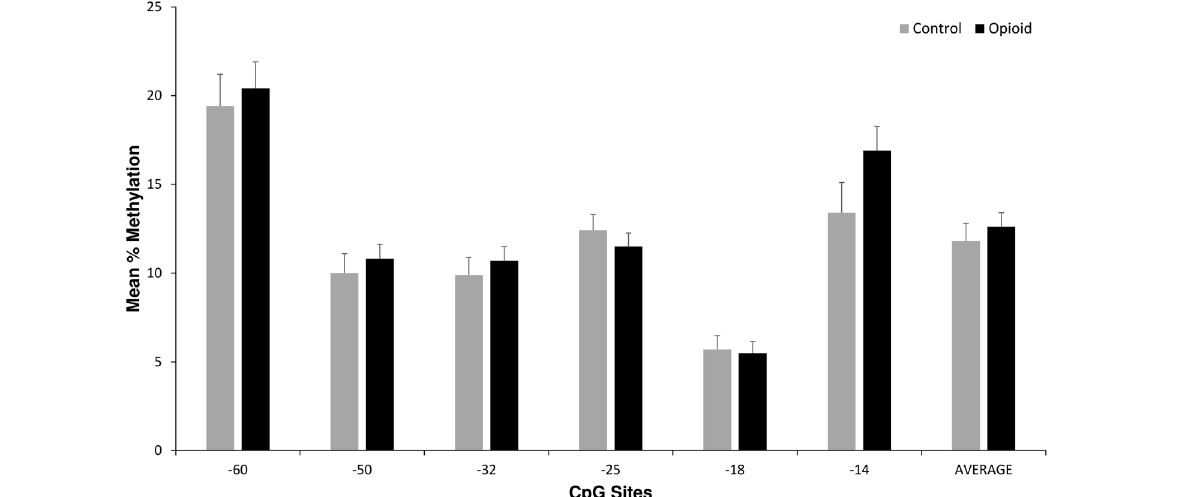
Figure 2. Placenta OPRM1 DNA methylation in control versus opioid subjects. Average placental OPRM1 methylation levels for CpG sites for the 64 opioid subjects compared with the 29 control subjects. There were no statistically significant differences in univariate or multivariate